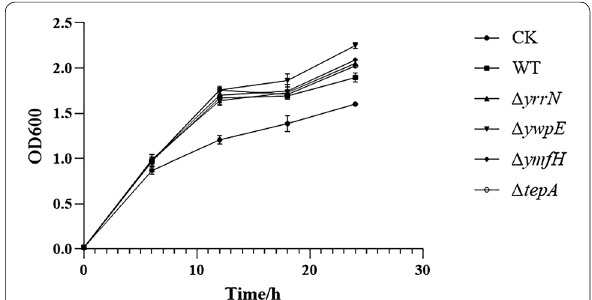
Fig. 3 Growth curve of intracellular protease‑deficient strains. CK, pWB980/BS1A751, wild‑type (WT), pWB980‑AIO6BS/BS1A751;